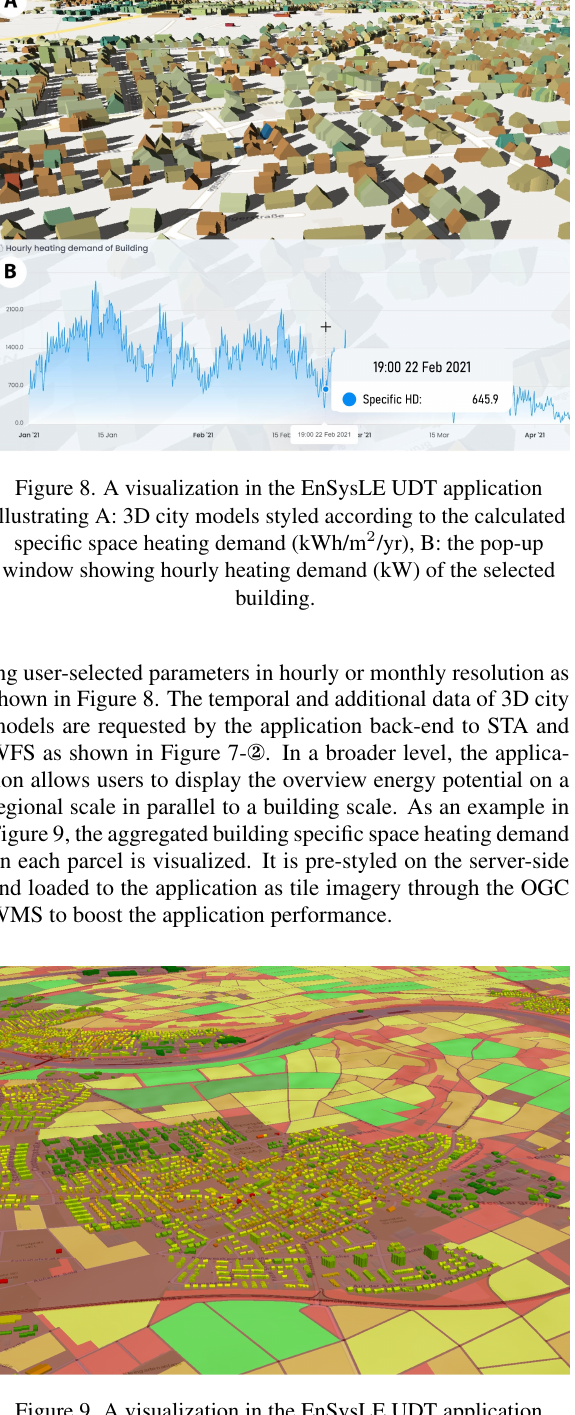
Figure 9. A visualization in the EnSysLE UDT application illustrating the building specific space heating demand (kWh/m 2 /yr)) per building and per land use parcel in the area of